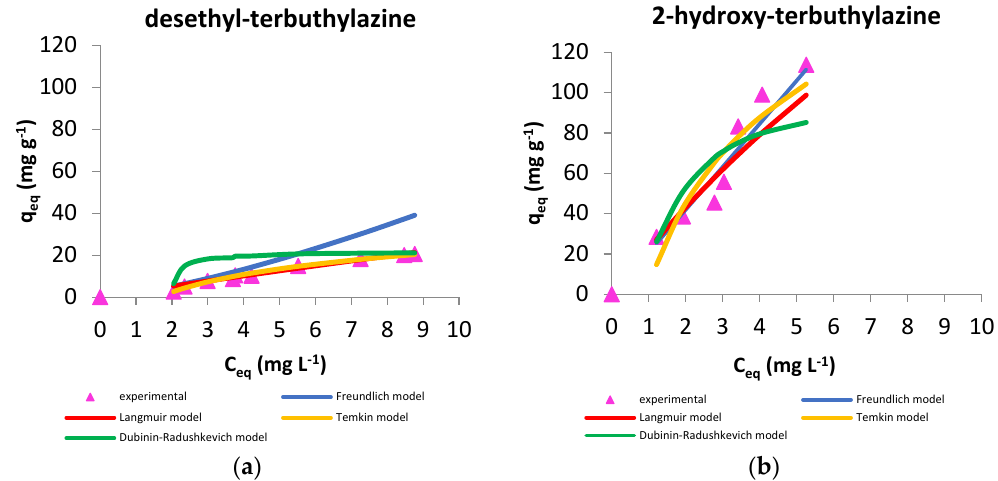
Figure 7. Experimental isotherms with predicted batch sorption model curves for desethyl-terbuthylazine ( a ) and 2-hydroxy-terbuthylazine ( b ).